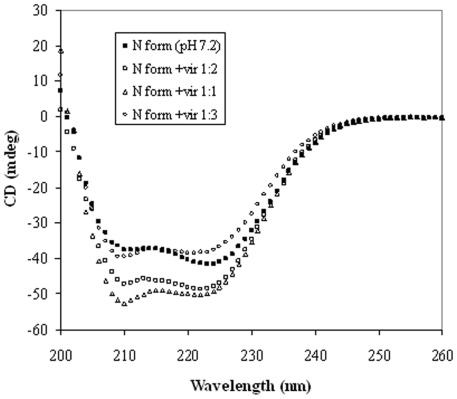
Far-UV CD spectra of the N isomer (pH 7.2) in the presence of virstatin, with HSA/virstatin molar ratios of 1∶1, 1∶2 and 1∶3.